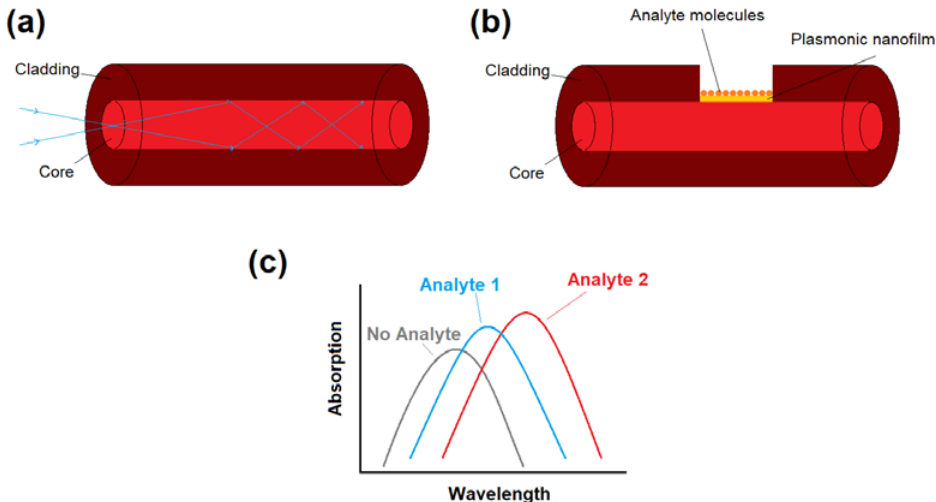
Figure 1. ( a ) Diagram of a conventional optical fiber with a total internal reflection light guiding mechanism. ( b ) Plasmonic fiber-optic biosensor can be obtained by removing a part of the optical